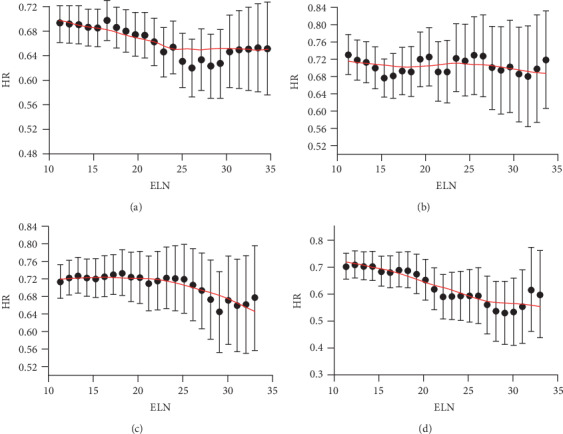
Fitting curves of right hemicolon resection (a), left hemicolon resection (b), sigmoid colon resection (c), and rectal resection (d).